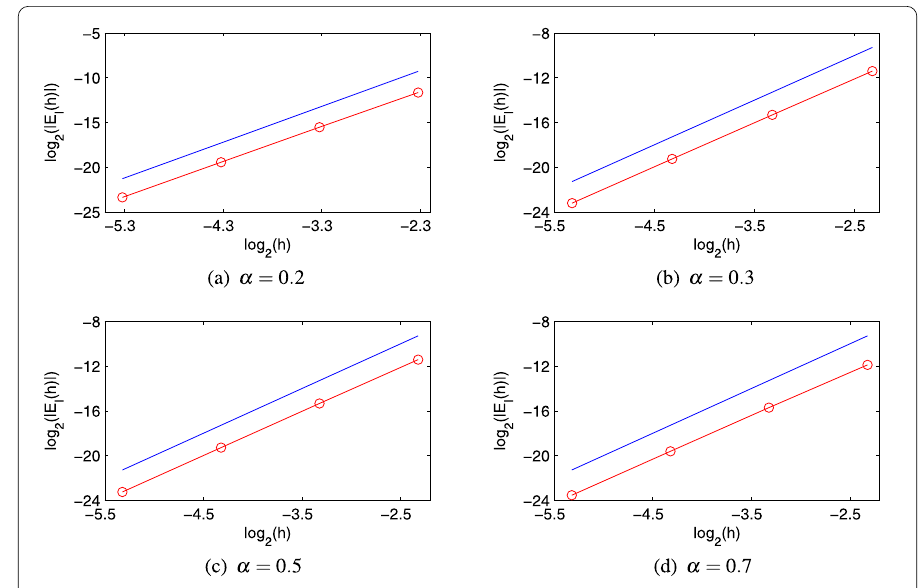
Figure 5 The experimentally determined orders of convergence for algorithm I at t = 1 for (31) with ν = 4